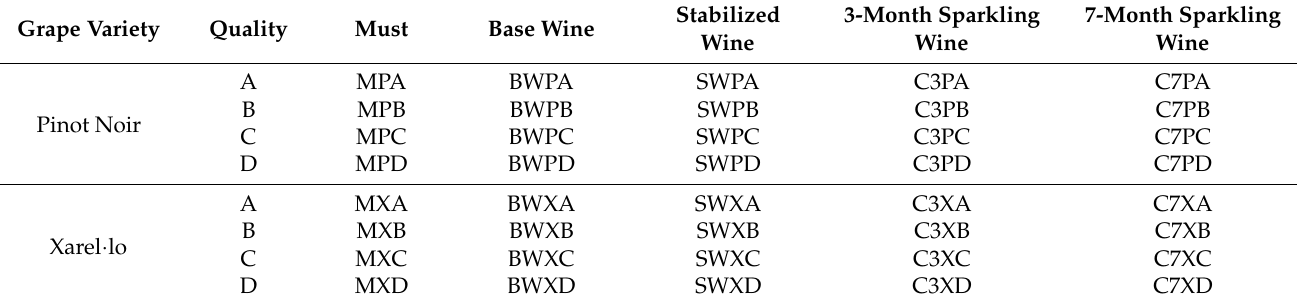
Table 2. List of samples under study. Sample codes are as follows: M, must; BW, base wine; SW, stabilized wine; C3, 3 months in rhyme cava wine (sparkling wine); C7, 7 months in rhyme cava wine (sparkling wine); P, Pinot Noir; X, Xarel · lo; A, quality A; B, quality B; C, quality C; D, quality D (reproduced from Ref.